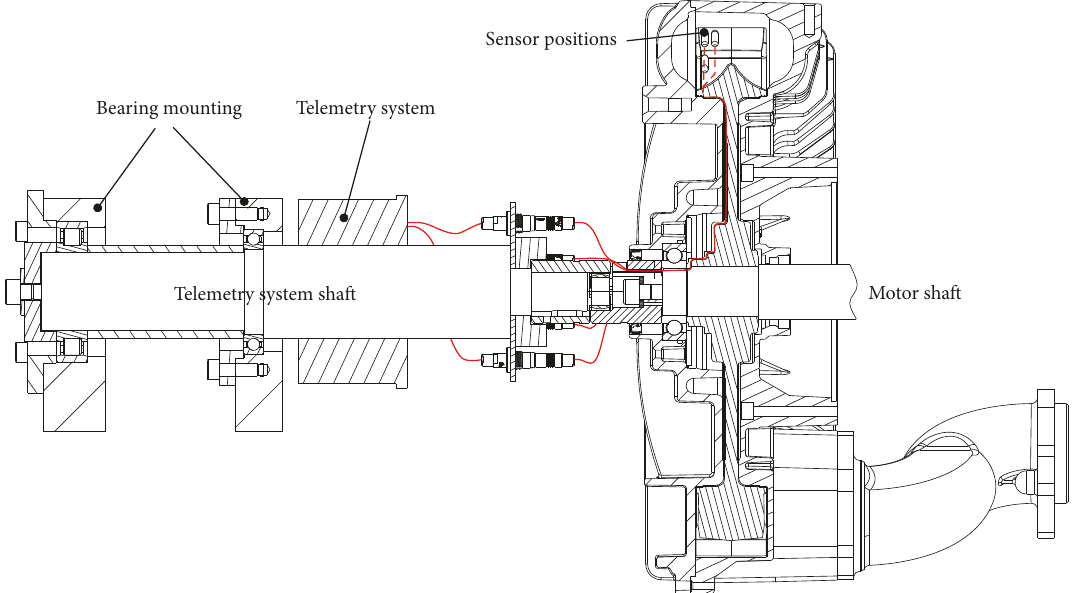
Figure 3: Setup for pressure measurements on the blade surface (support frame, motor, and balancing bodies not shown) with sensor cables in red.